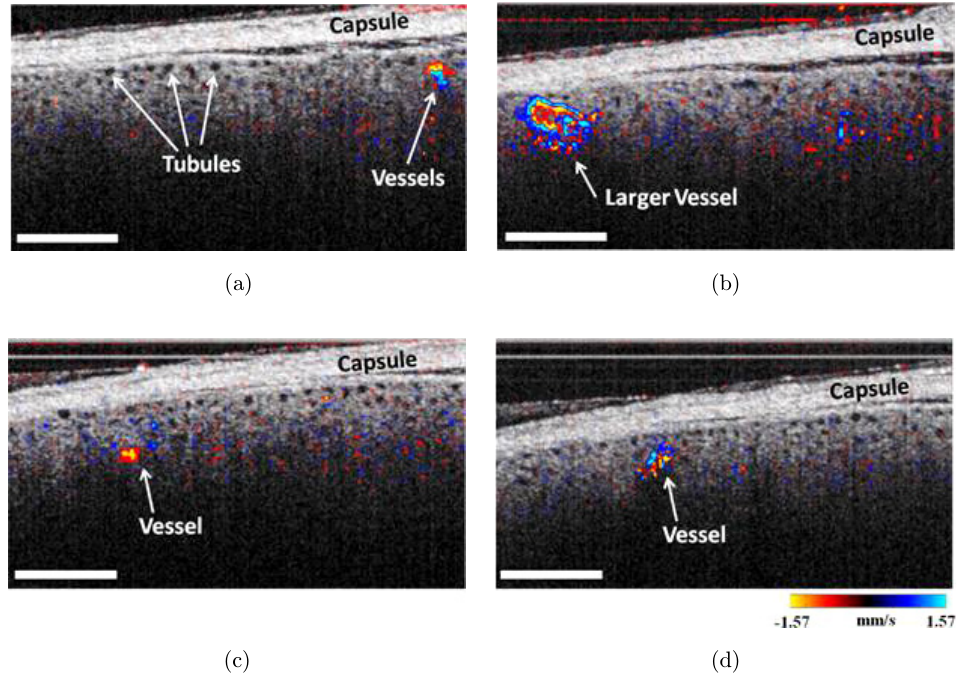
Fig. 5. In vivo human kidney showing open tubules and conical blood °ow. Open tubules appear round and relatively uniform across all images. Also, a larger blood vessel is seen in (b) against some smaller vessels observed in (a), (c) and (d). Data are from a single patient. Scale bar ¼ 500 (cid:1)